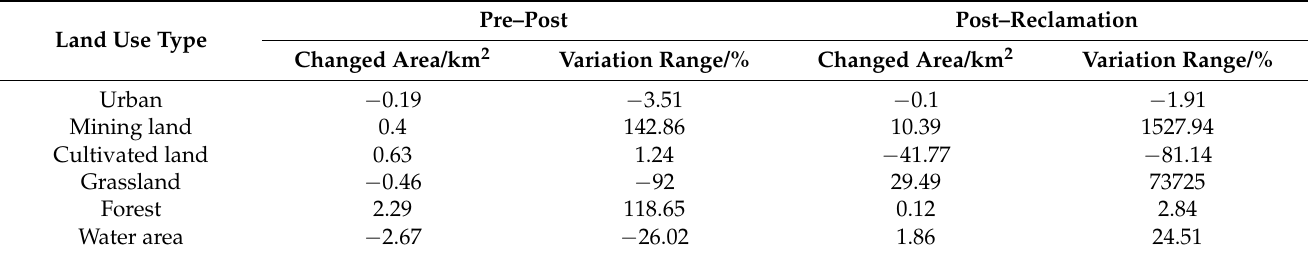
Table 6. Change in land use